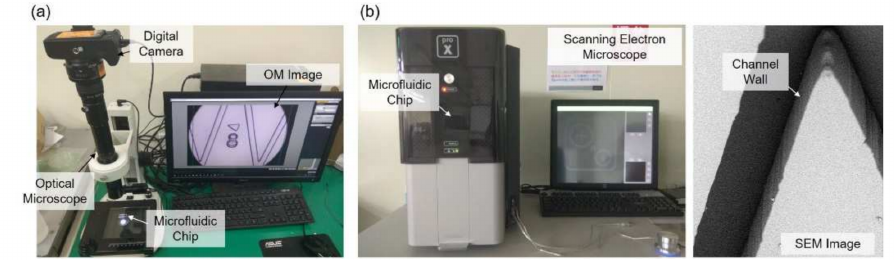
Figure 3. Microscopes for obtaining images. ( a ) Optical microscope. ( b ) Scanning electron microscope and a sample image taken from